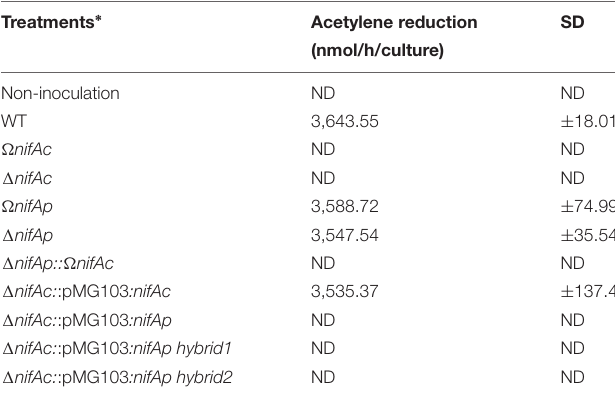
TABLE 1 | Nitrogenase activity in Bradyrhizobium sp. DOA9 (WT) and nifA mutant strains grown under free-living conditions as described in Material and Methods. Treatments